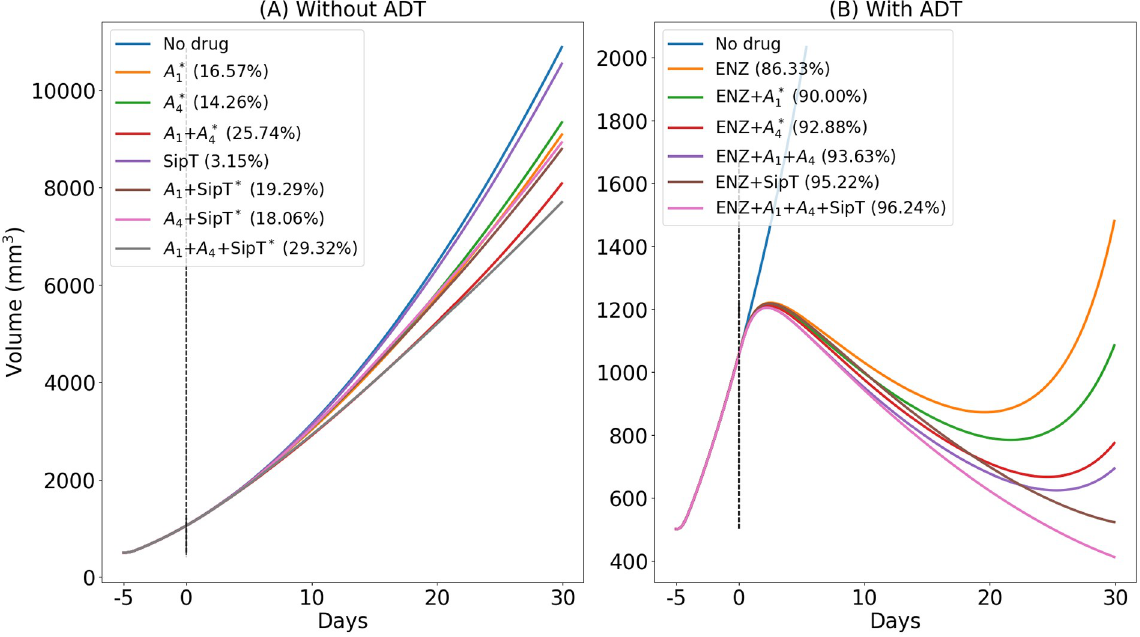
Fig 4. Simulation of the average densities/concentrations of the variables for model (2)–(21)with ENZ, Sip-T, anti-PD-1 ( A 1 ) and anti- CTLA-4 ( A 4 ). The “%” represents the percentage decrease relative to no-treatment at day 30; the symbol “ � ” indicates treatments which are currently undergoing clinical trials. All parameters are as in S1 File. Tables 1 and 2, with g 10 − 6 , in g/cm 3 � d. https://doi.org/10.1371/journal.pone.0262453.g004 PLOS ONE | https://doi.org/10.1371/journal.pone.0262453 January 11,